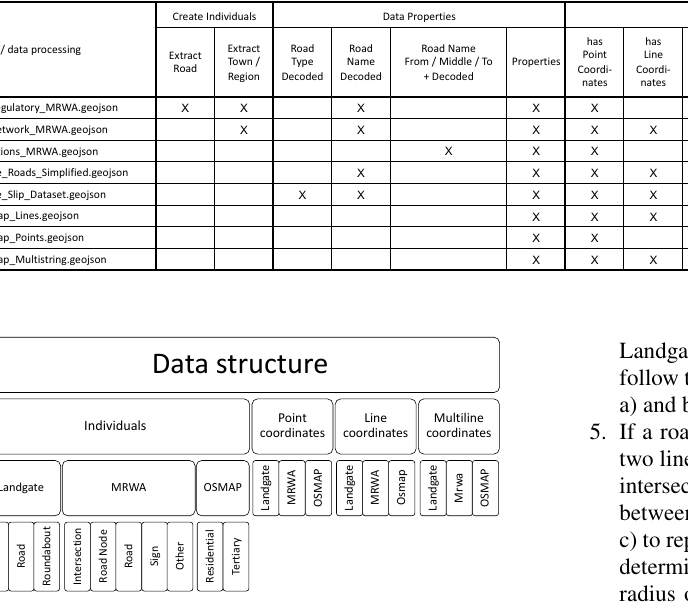
Figure 7. Data structure generated with script (P2).